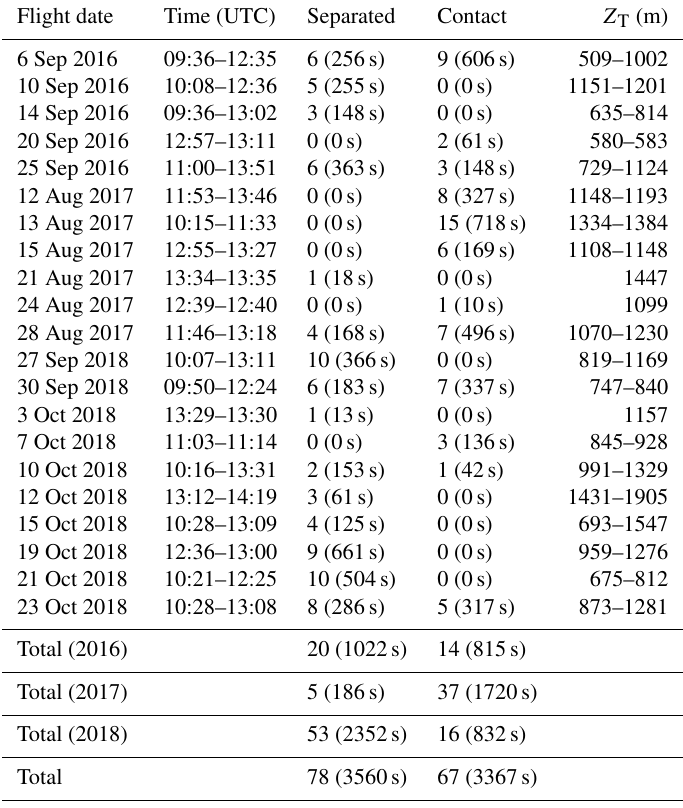
Table 1. List of research flights analyzed and the time range, number, sampling duration (in parentheses), and cloud top height ( Z T ) for profiles with a co-located MODIS retrieval with a time gap ( (cid:49)T ) of less than 3600s. Number and duration are listed for profiles classified by above-cloud aerosol location.